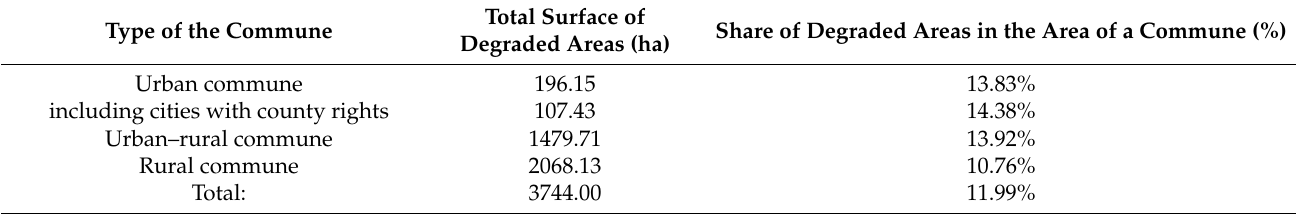
Table 5. Surface of degraded areas in the respective types of the